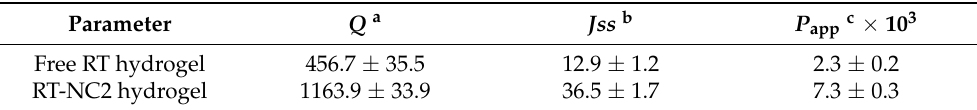
Table 7. Ex vivo permeation parameters of RT from free drug hydrogel and RT-NC2 hydrogel through mouse abdominal